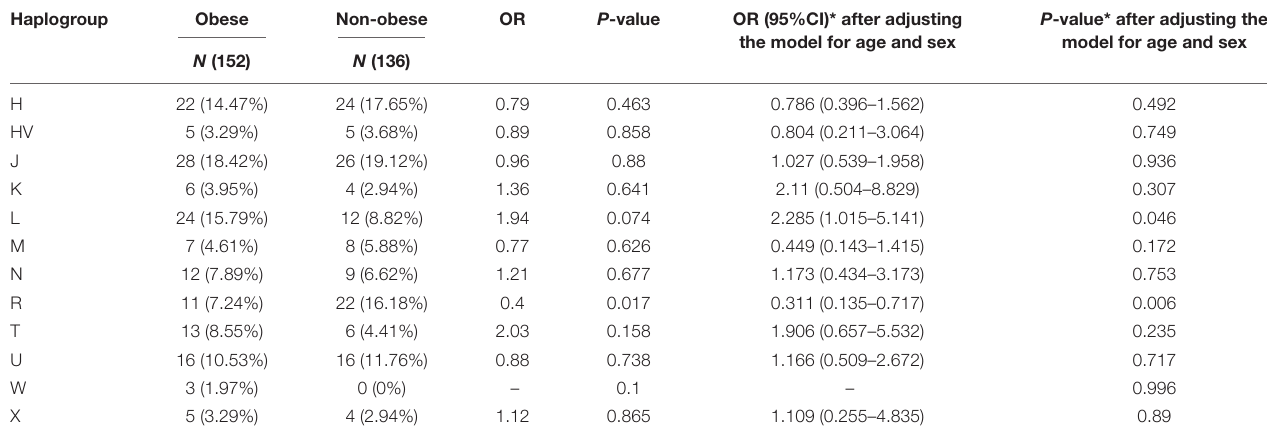
FIGURE 2 | Principal component analysis (PCA) of the 288 Kuwaiti samples based on their mtDNA. (A) The two colors represent obese and non-obese samples, and the colors on (B) represent haplogroup origin of each sample. PC1 and PC2 on the x - and y -axes represent principal component 1 and principal component 2 and their variations in percentage, respectively. TABLE 2 | Mitochondrial haplogroups associated with obesity in the Kuwaiti population.